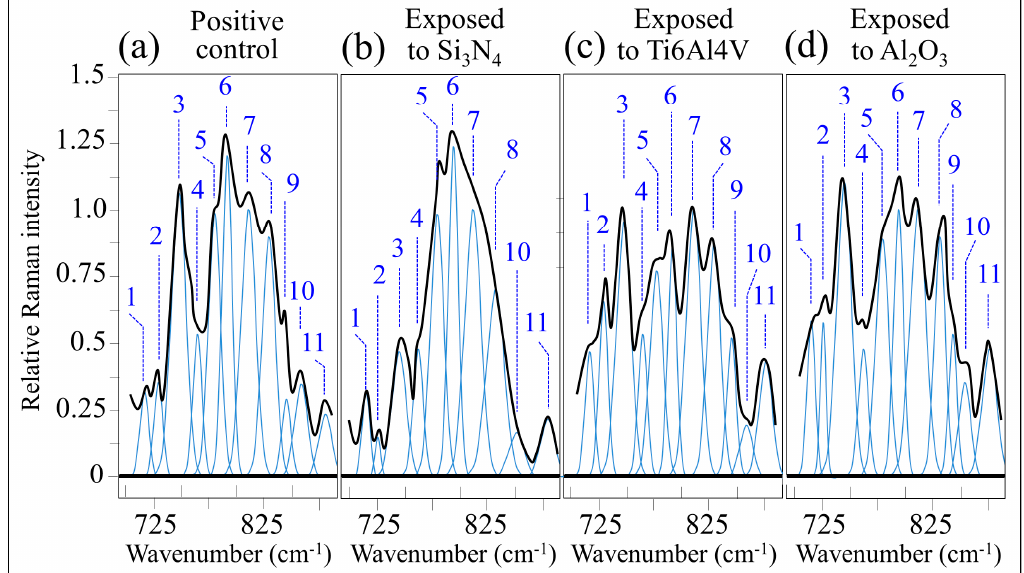
Figure 5. Low-frequency Raman spectra for ( a ) positive control cell sample, ( b ) cells exposed for 48 h to Si 3 N 4 substrate, ( c ) cells exposed for 48 h to Ti6Al4V alloy substrate, and ( d ) cells exposed for 48 h to Al 2 O 3 substrate. All the spectra were normalized to Band 7 (at 813 cm − 1 , related to symmetric stretching of the phosphodiester bonds of RNA [25–27]).